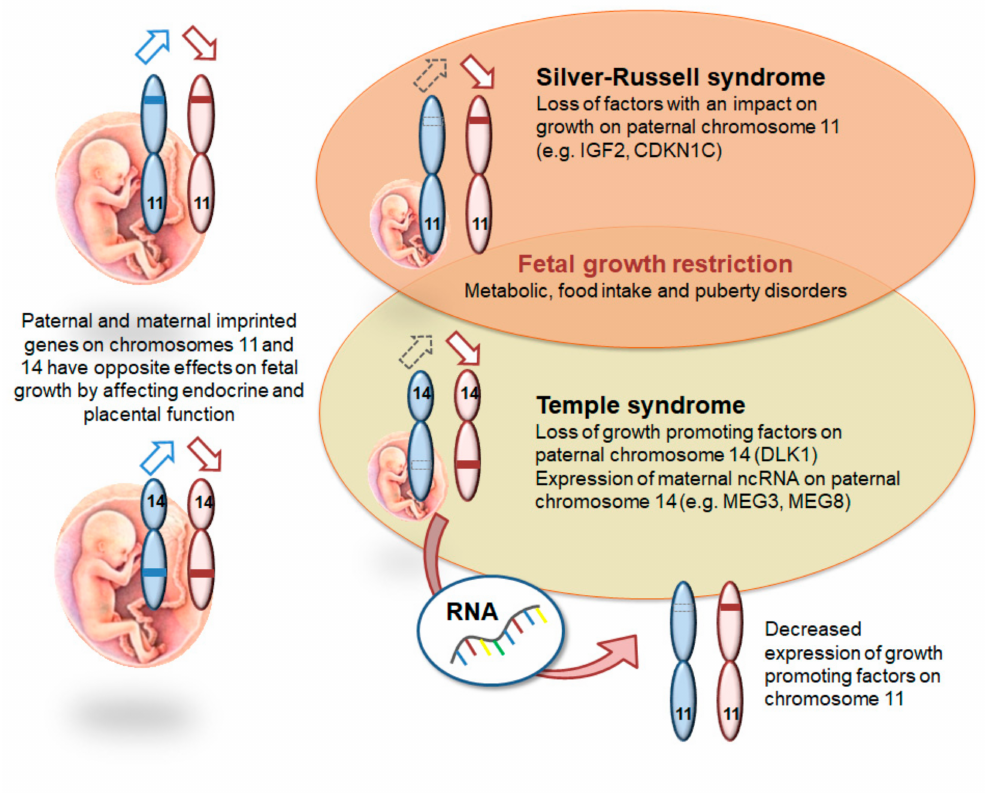
Figure 2. Interaction of imprinted genes on chromosomes 11 and 14 and (putative) functional relation between Silver-Russell and Temple